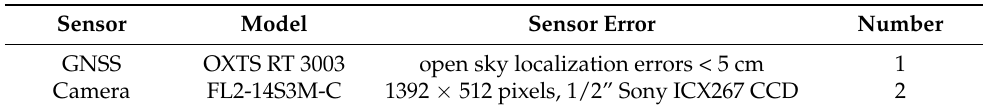
Table 1. List of sensor simulation